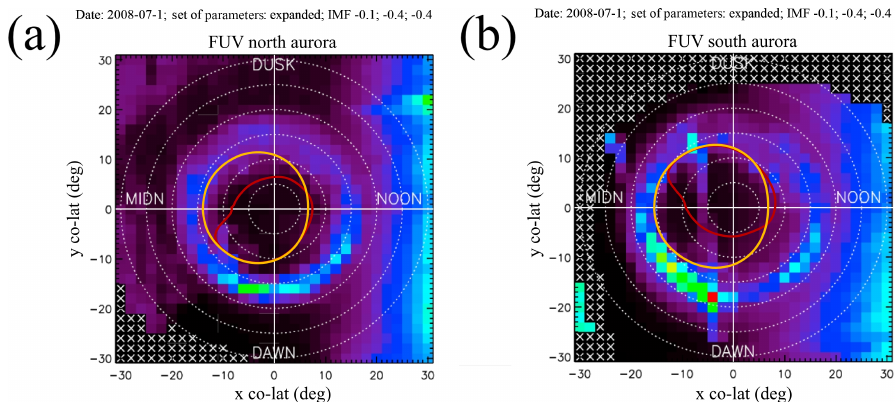
Figure 11. As for Fig. 10, but for a southward IMF vector ( − 0.1, − 0.4, −